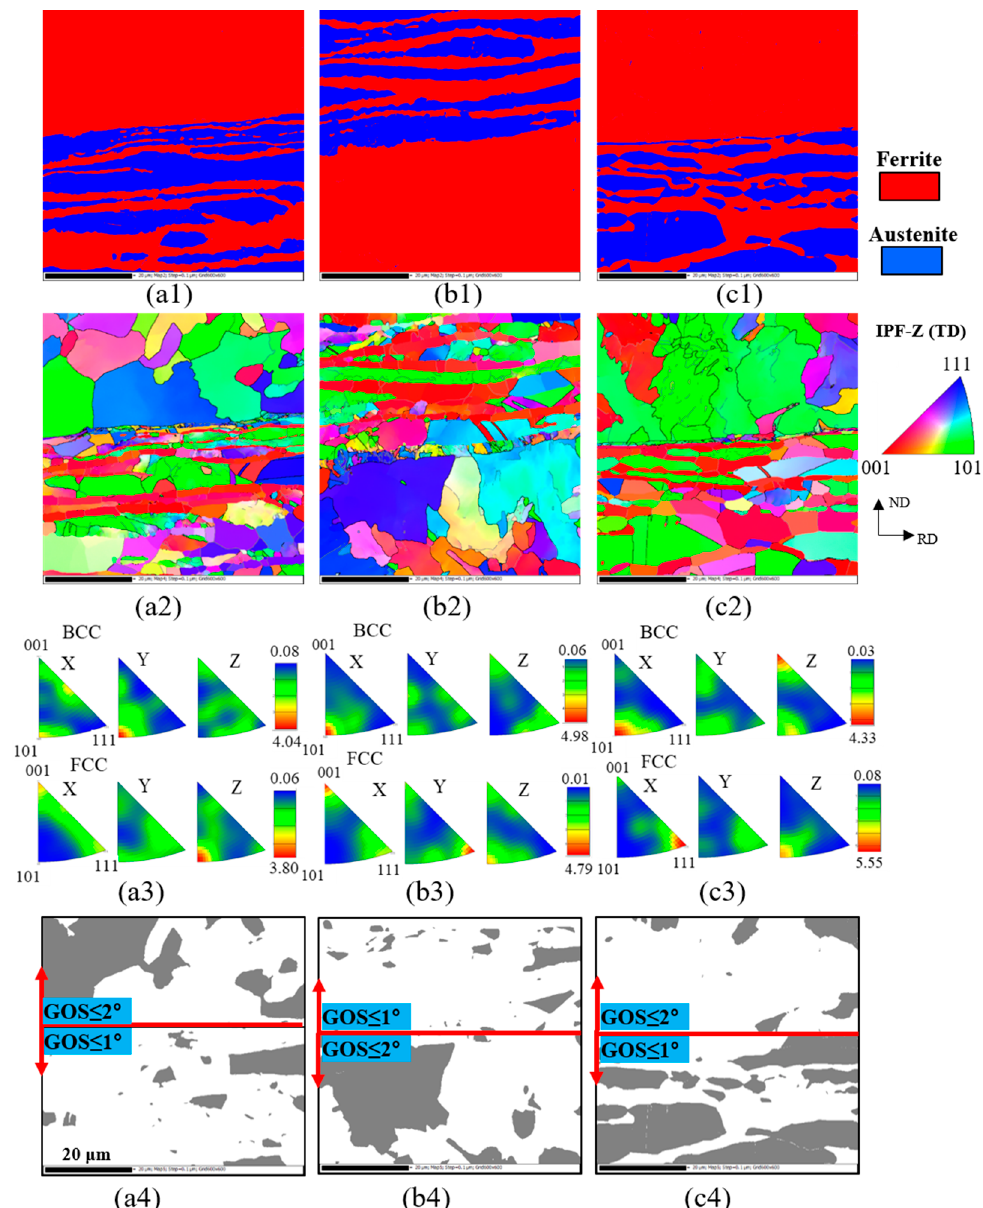
Figure 10. The phase, orientation map IPF-Z direction, IPF and GOS maps of specimens after hot bending: ( a1–a4 ) at 950 °C with the outside 2205 steel layer, ( b1 – b4 ) at 950 °C with the inside 2205 steel layer and ( c1 – c4 ) at 1050 °C with the outside 2205 steel layer. LAGBs = gray, HAGBs = black.